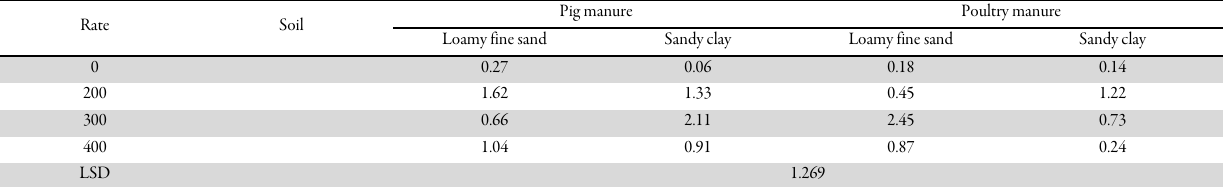
Table 11. Interaction between types and rates of manure and soil texture on tuber weight (g/plant) of tiger nut at 20 cm soil depth at harvest. Values are a mean of 5 plants Rate Soil